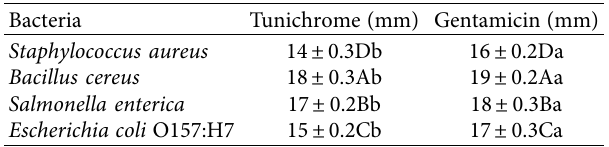
Data represent mean ± standard deviation of three independent repeats. Different capital letters in each column and lowercase ones in each row indicate significant differences ( P < 0.05). Table 9: MIC and MBC values of tunichrome released from Phallusia nigra Persian Gulf marine tunicate.